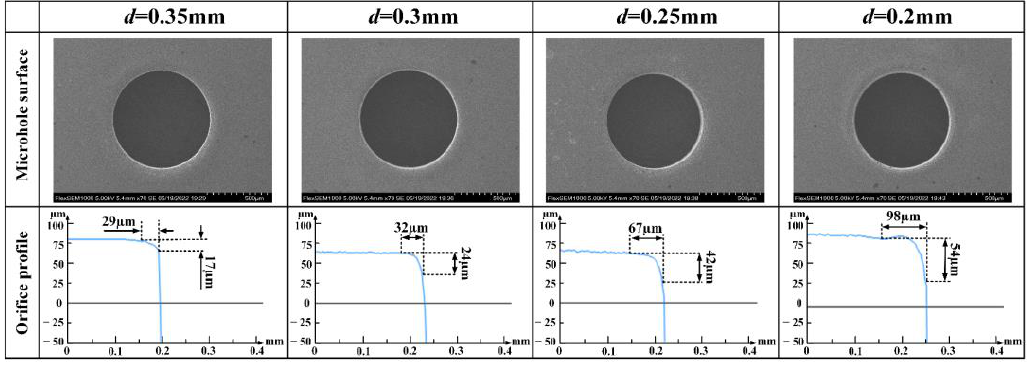
Figure 19. Influence of initial machining gap on orifice chamfer.